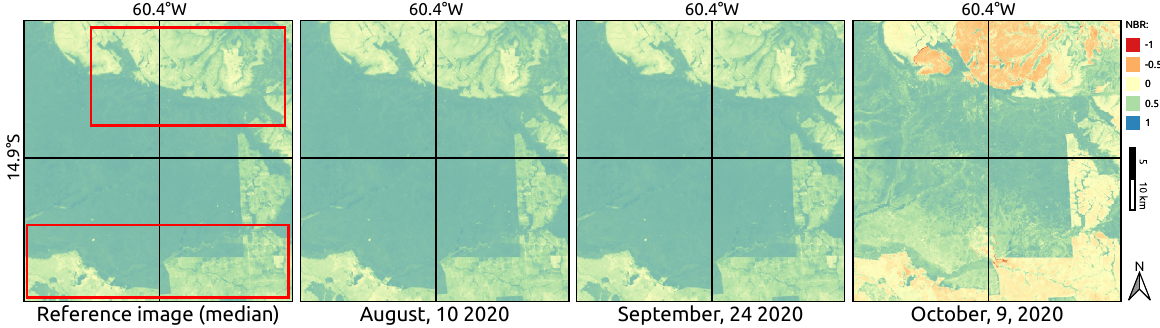
Figure 7. The NBR behavior for the reference image and individual instants regarding Area 1. Regions delimited by red rectangles highlight places with potential changes over time.